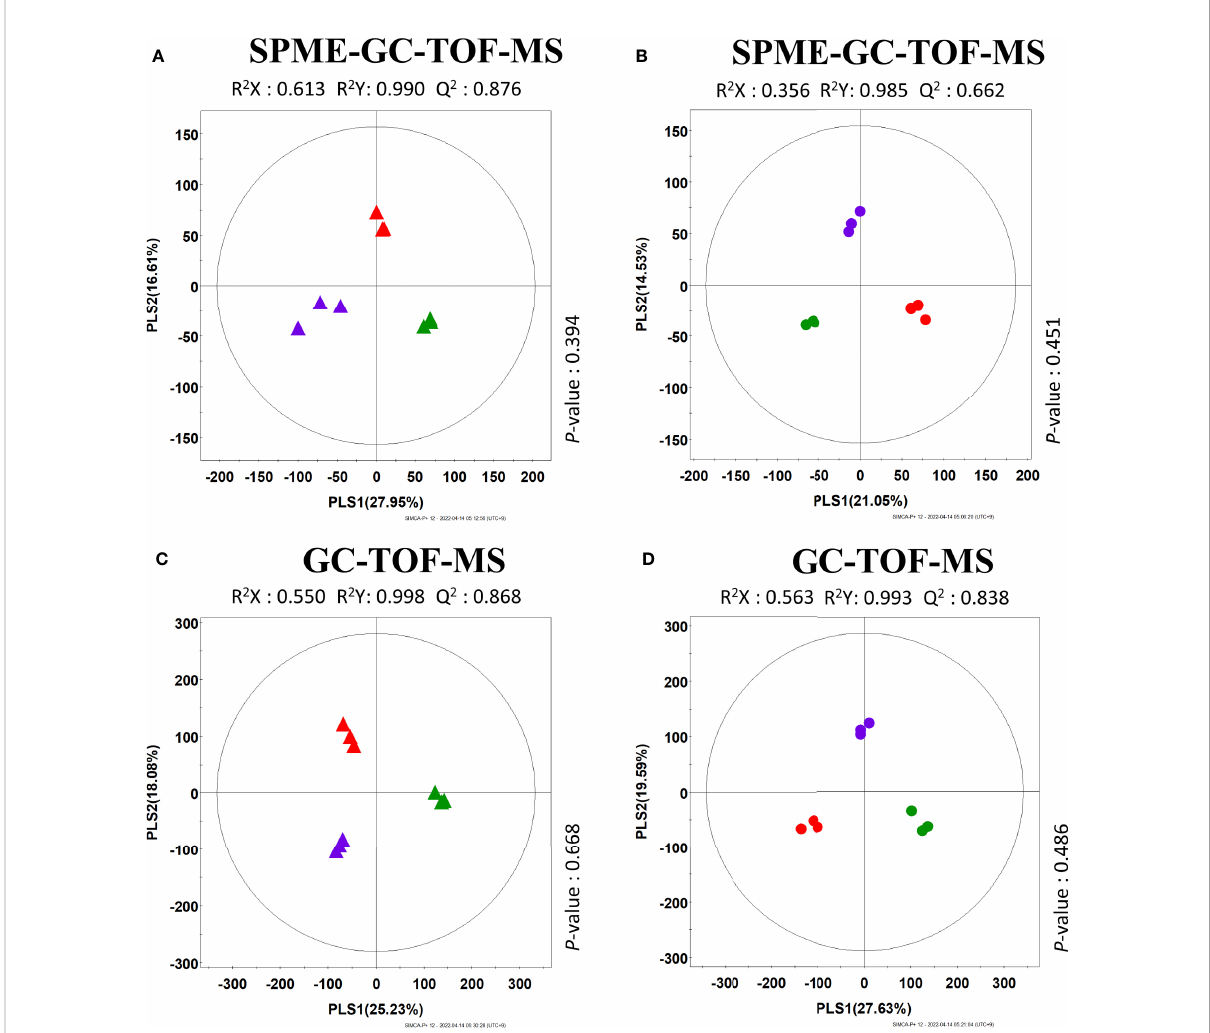
FIGURE 3 PLS-DA score plots of different three cucumbers based on SPME-GC-TOF-MS (A, B) and GC-TOF-MS (C, D) data set. (A, C) are the results of analyzing different peel data. (B, D) are the results of analyzing different fl esh data. Different sample symbolized as: Peel ( ▲ : SJ24 (Korea group), ▲ : SJ62 (Europe group), ▲ : SJ109 (Thailand group)), fl esh ( ● : SJ24 (Korea group), ● : SJ62 (Europe group), ● : SJ109 (Thailand